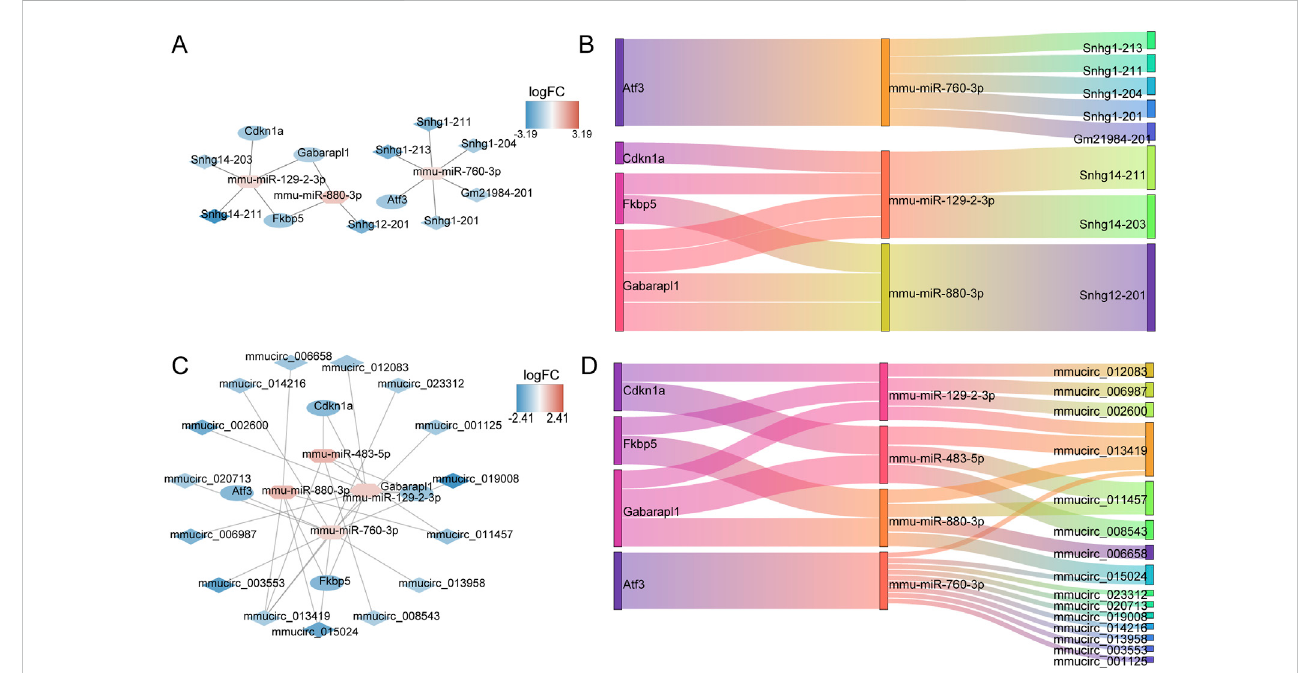
FIGURE 6 Construction of ceRNA networks for 13 DE-ERSRGs. (A) mRNA-miRNA-lncRNA regulatory network. (B) Sankey diagram of the mRNA-miRNA-lncRNA regulatory. (C) mRNA-miRNA-circRNAregulatorynetwork. (D) SankeydiagramofmRNA-miRNA-circRNAregulatory.InthemRNA-miRNA-lncRNA(circRNA) network, the hexagon represents miRNA, the rhombus represents lncRNA (circRNA), the oval represents mRNA, and the color represents logFC value. The closer the color is to red, the more upregulated the expression is, and the closer the color is to blue, the downregulated the expression